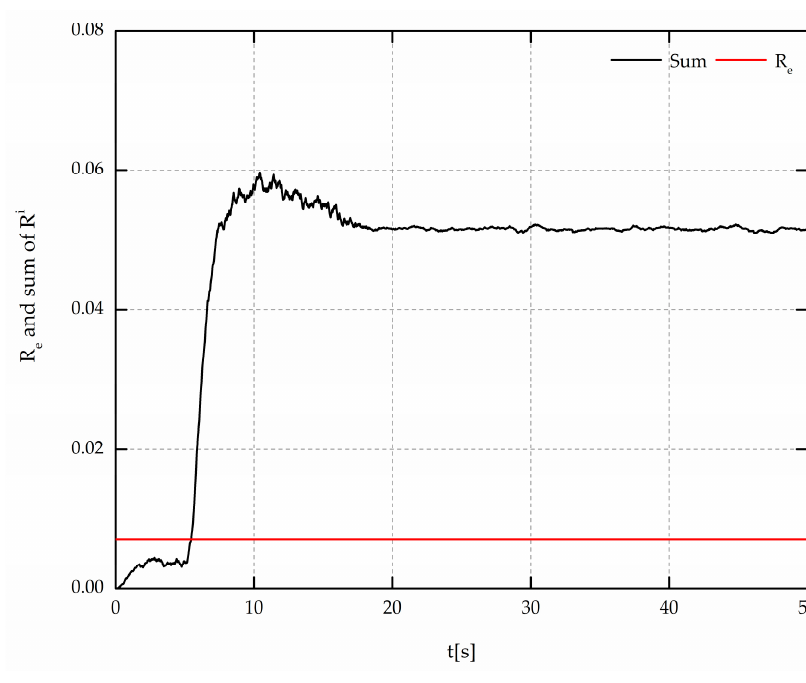
Figure 5. Comparison between threshold and sum of indicators in Mode 1.